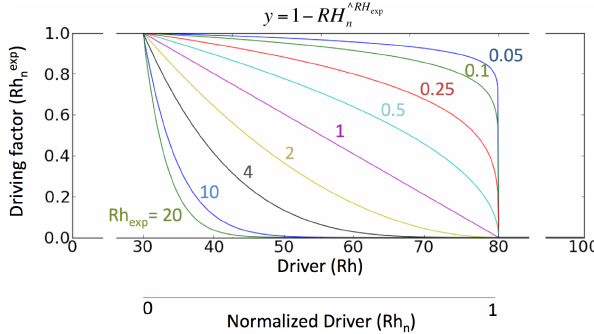
Figure 2. Control of shape parameters (exponents, here RH exp ) on fire-driving relationships. The exponent can take any value (from 0.033 to 30) as determined by the optimization procedure, thus cov- ering a wide space of potential fire-driving influence.